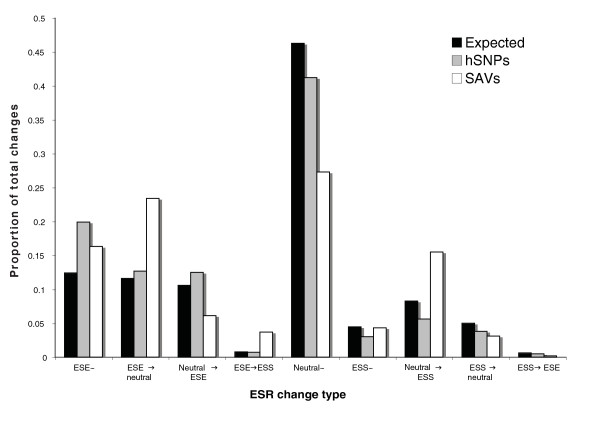
Distribution of specific types of NI-ESR changes for SAVs and hSNPs compared to neutral expectation. The tilde symbol (~) signifies an alteration where the hexamer is designated an ESE, neutral or ESS in both the wild-type and variant sequences. The arrow represents the direction of the change as a consequence of the change between wild type and variant hexamer. The neutral expected distribution reflects the underlying probability of each type of change given the ESE/ESS distribution among NI hexamers and the genome-wide nucleotide substitution bias in coding regions.